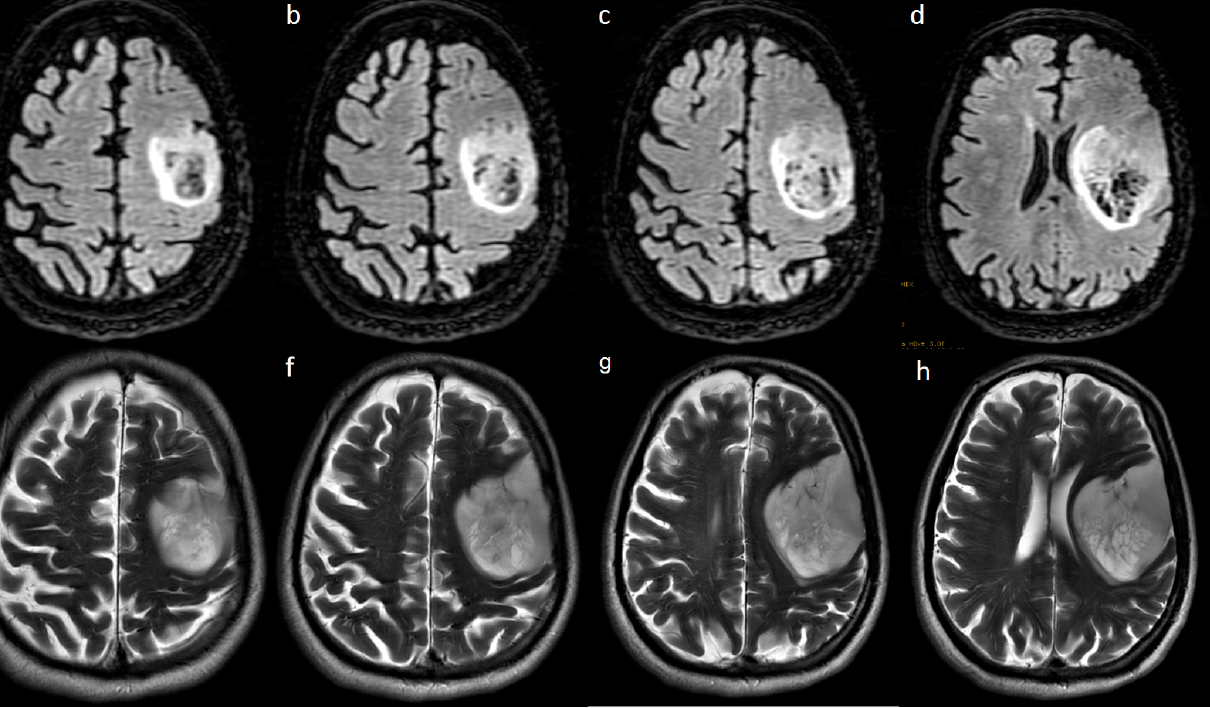
Figure 7. Axial FLAIR ( a – d ) and T2w ( e – h ) images reveal a T2-FLAIR mismatch sign in the form of hypointensity within the central part with the hyperintense rim on FLAIR, while both are hyperintense on T2.